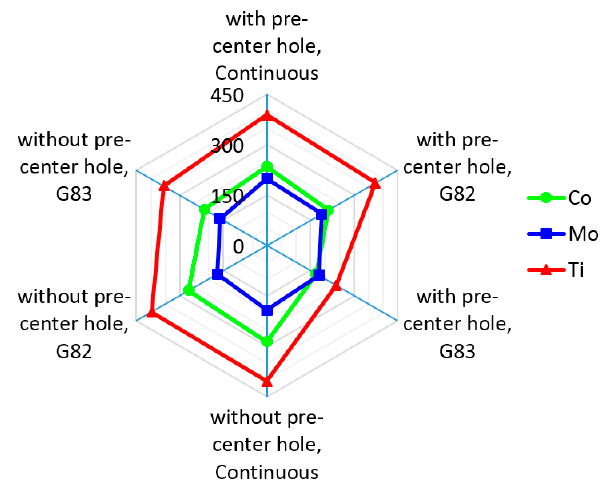
Figure 4. Cutting thrust force results for different cutters and strategies.